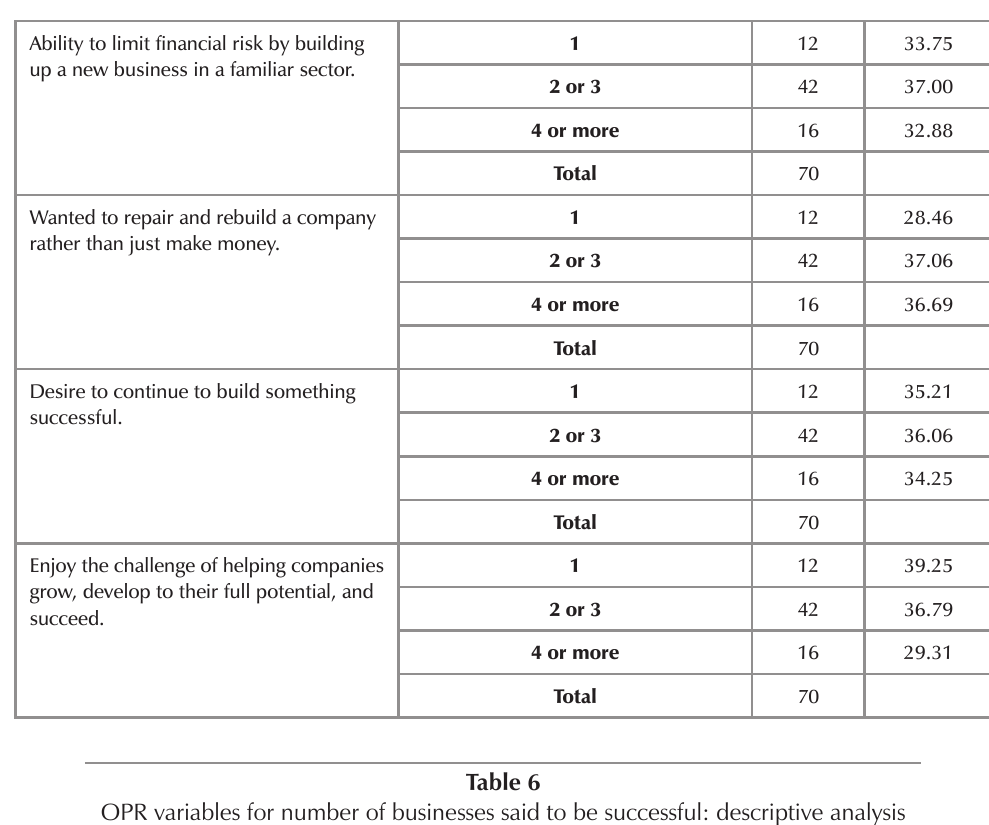
OPR variables for number of businesses said to be successful: descriptive analysis OPR variables How many of these new business opportunities can be said to be